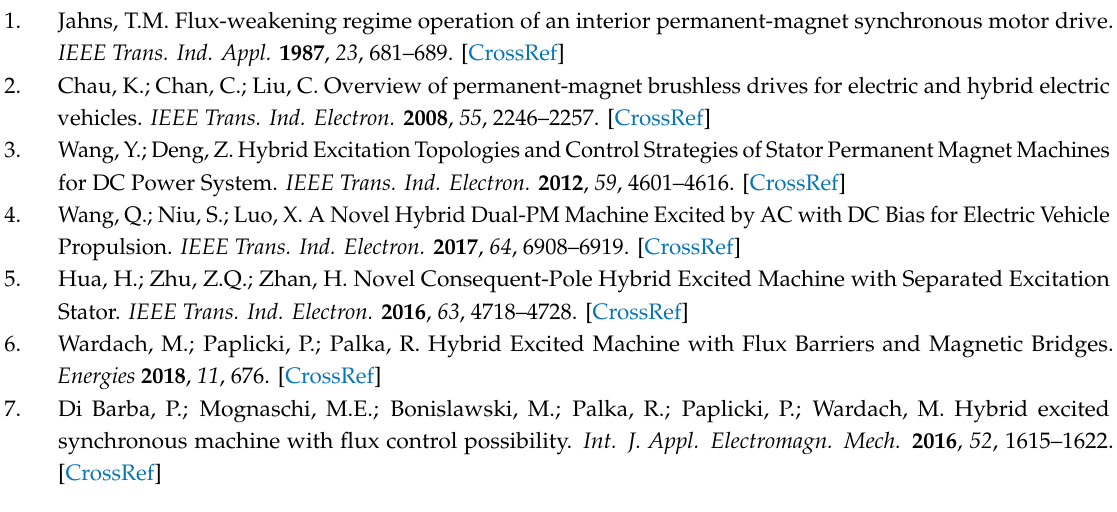
Figure 16. Experimental results of back-EMF versus DC coil current (1000 rpm).